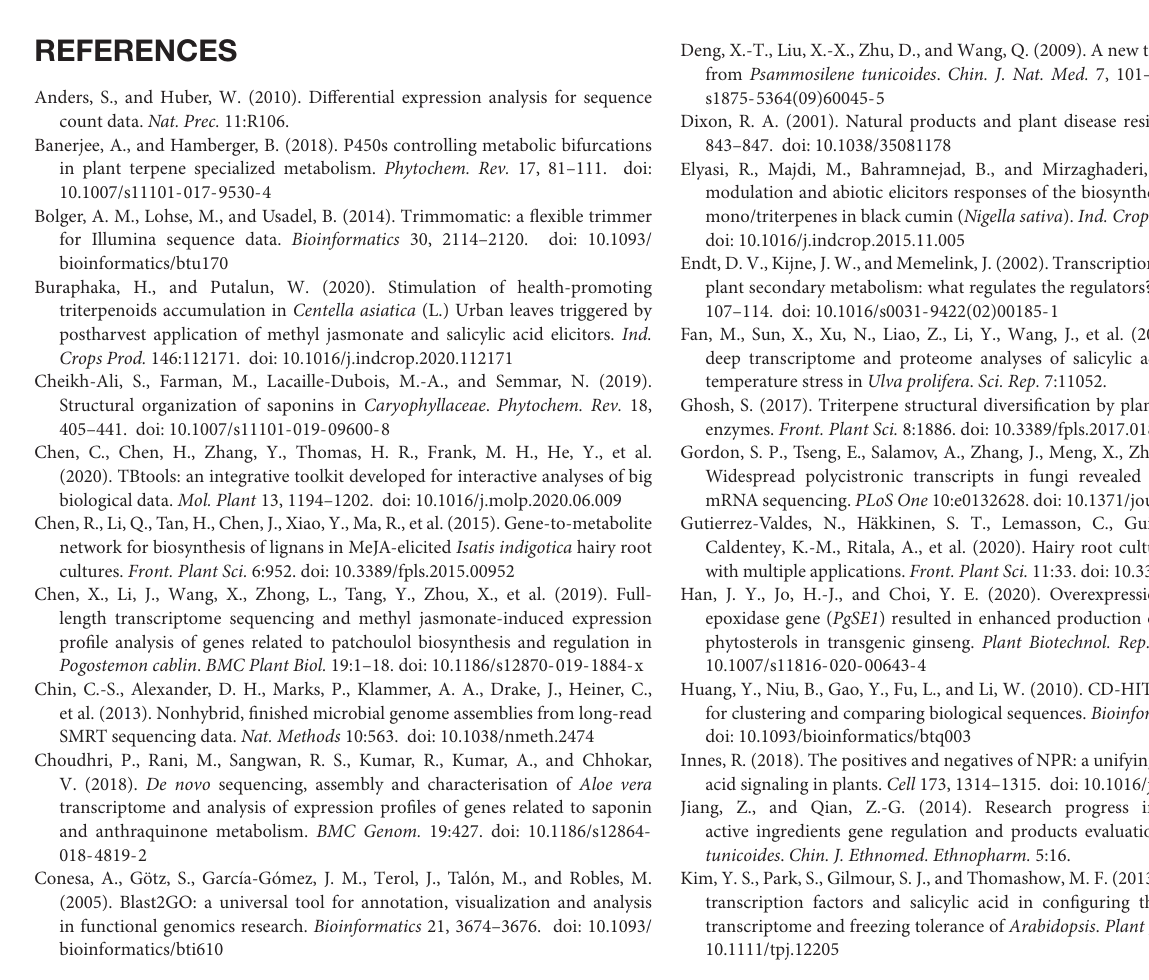
Supplementary Figure 1 | HPLC analysis of two representative saponin aglycones in P. tunicoides hairy root extracts with SA elicitation. Supplementary Figure 2 | Length distribution of lncRNAs and mRNAs. Supplementary Figure 3 | Effects of SA on antioxidant enzyme activities. Supplementary Table 1 | Sequence of primer pairs used in qRT-PCR analysis. Supplementary Table 2 | Summary of the transcriptome data from Illumina platform. Supplementary Table 3 | Summary of genes related to secondary metabolism based on KEGG